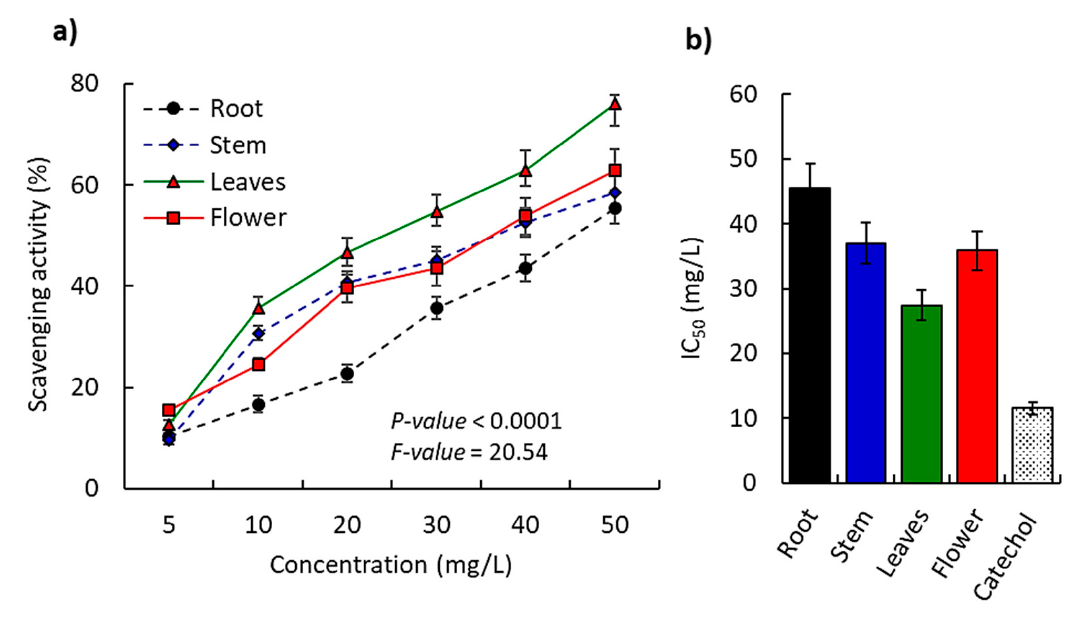
Figure 6. ABTS radical scavenging activity at different concentrations of the different parts of M. longipetala methanol extract ( a ), and IC 50 values ( b ). Values are average ( n = 3), and the bars represented the standard deviation.